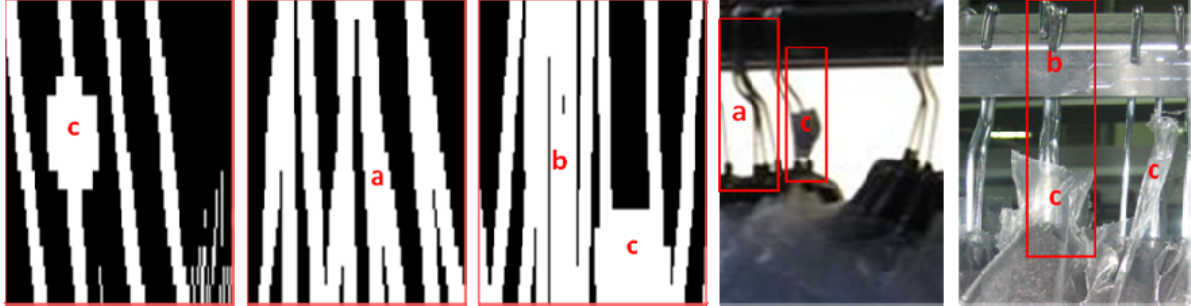
Figure 9. Cases and problems in real image and scanned image: ( a ) crossed hangers, ( b ) overlapped and aligned hangers, ( c ) obstacles in the